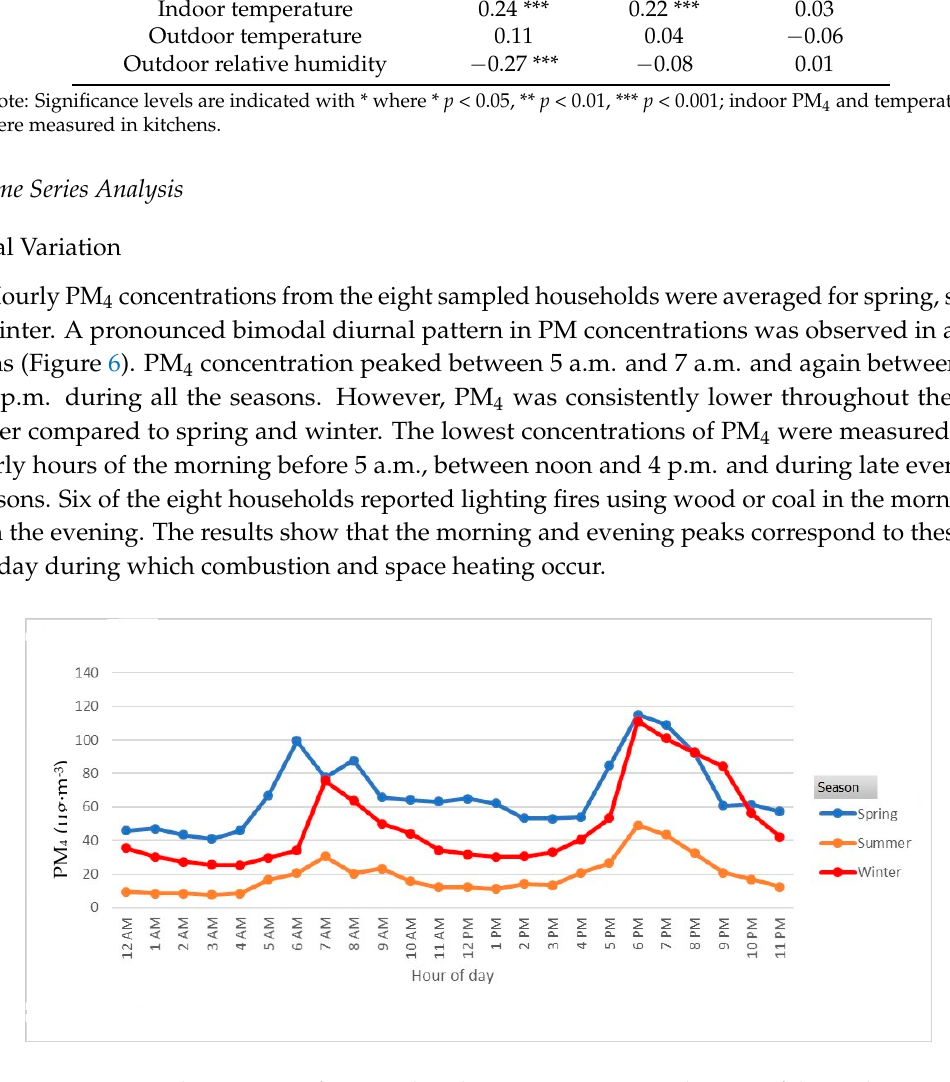
Table 3. Pearson’s correlation coefficients showing the correlation between PM 4 , temperature and relative humidity, stratified by season.